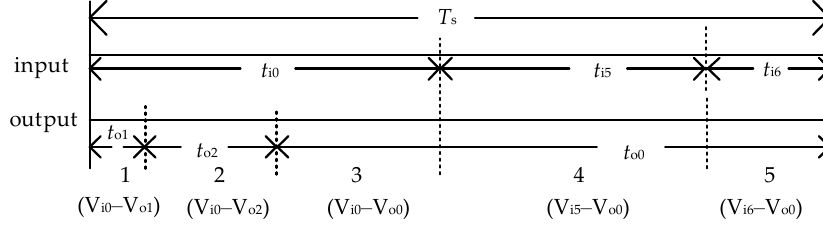
Figure 5. Timing of space vector.